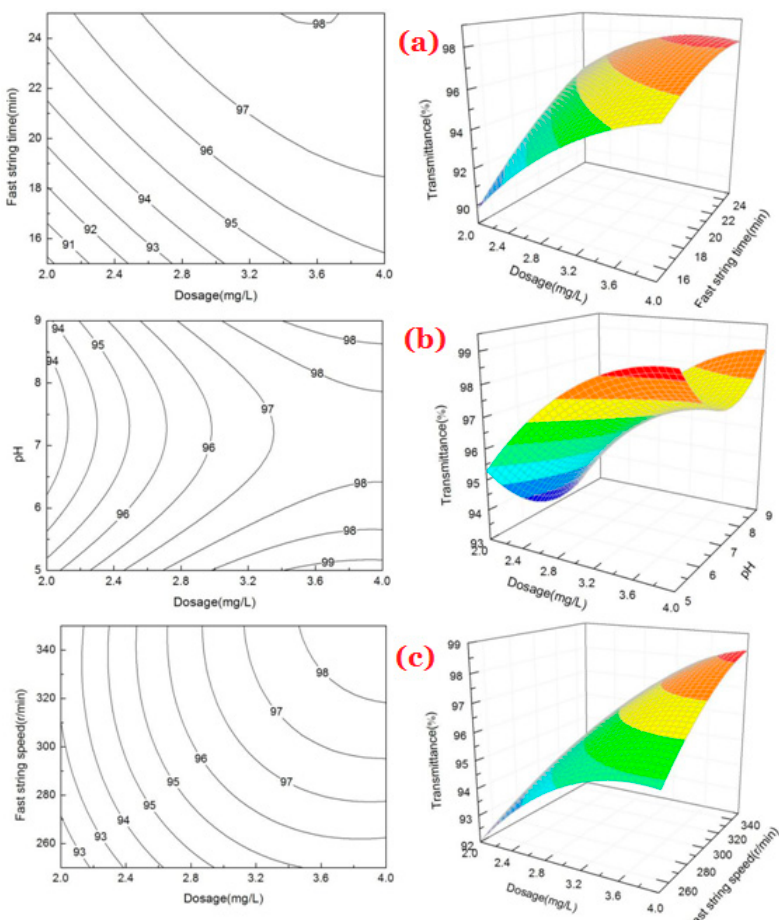
Figure 8. Response surface plotted and contour map of ( a ) dosage and fast stirring time, ( b ) dosage and pH, ( c ) dosage and fast stirring speed.